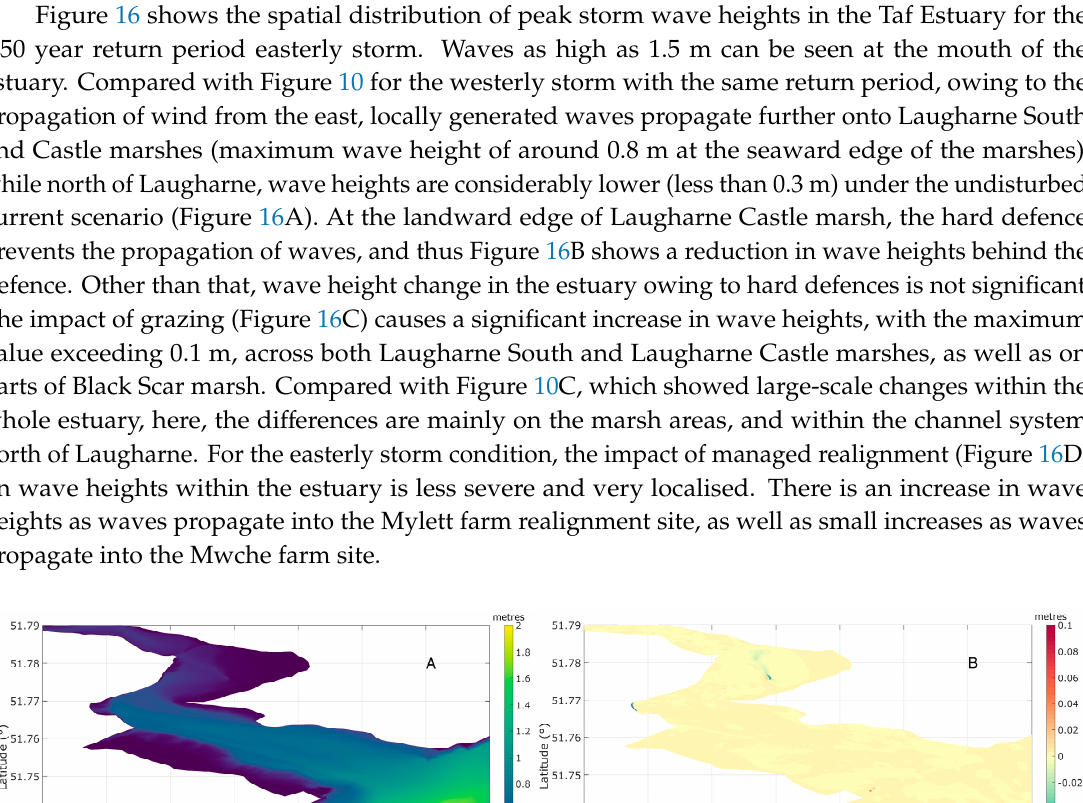
21 of 30 Figure 15. Comparison of peak storm wave height for the 1:50 year south ‐ westerly storm condition at